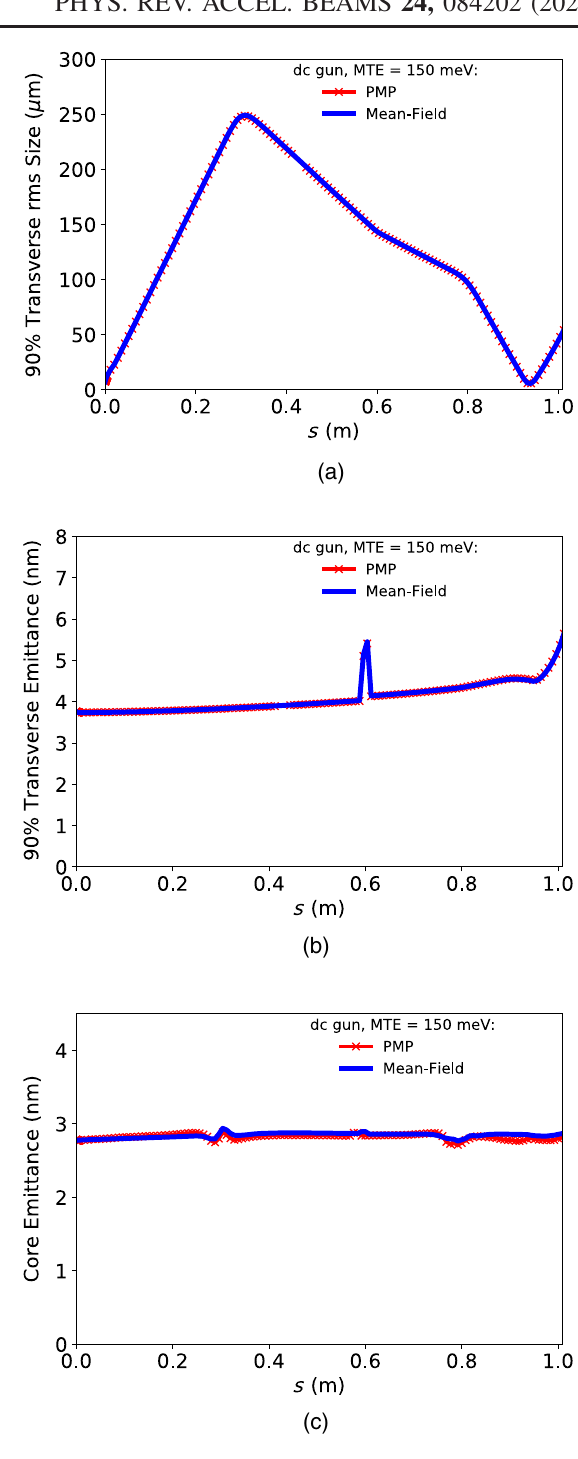
FIG. 14. (a) Spot size, (b) transverse normalized rms emittance, and (c) core emittance comparison between the PMP method and mean-field space charge simulations of the dc UED beamline with 150 meV